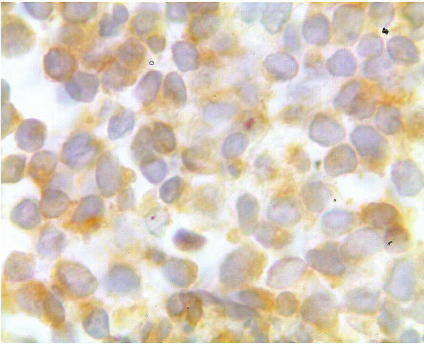
Figure 5: Immunohistochemical stain detected neoplastic cells positive for CD79a; original magnification ×